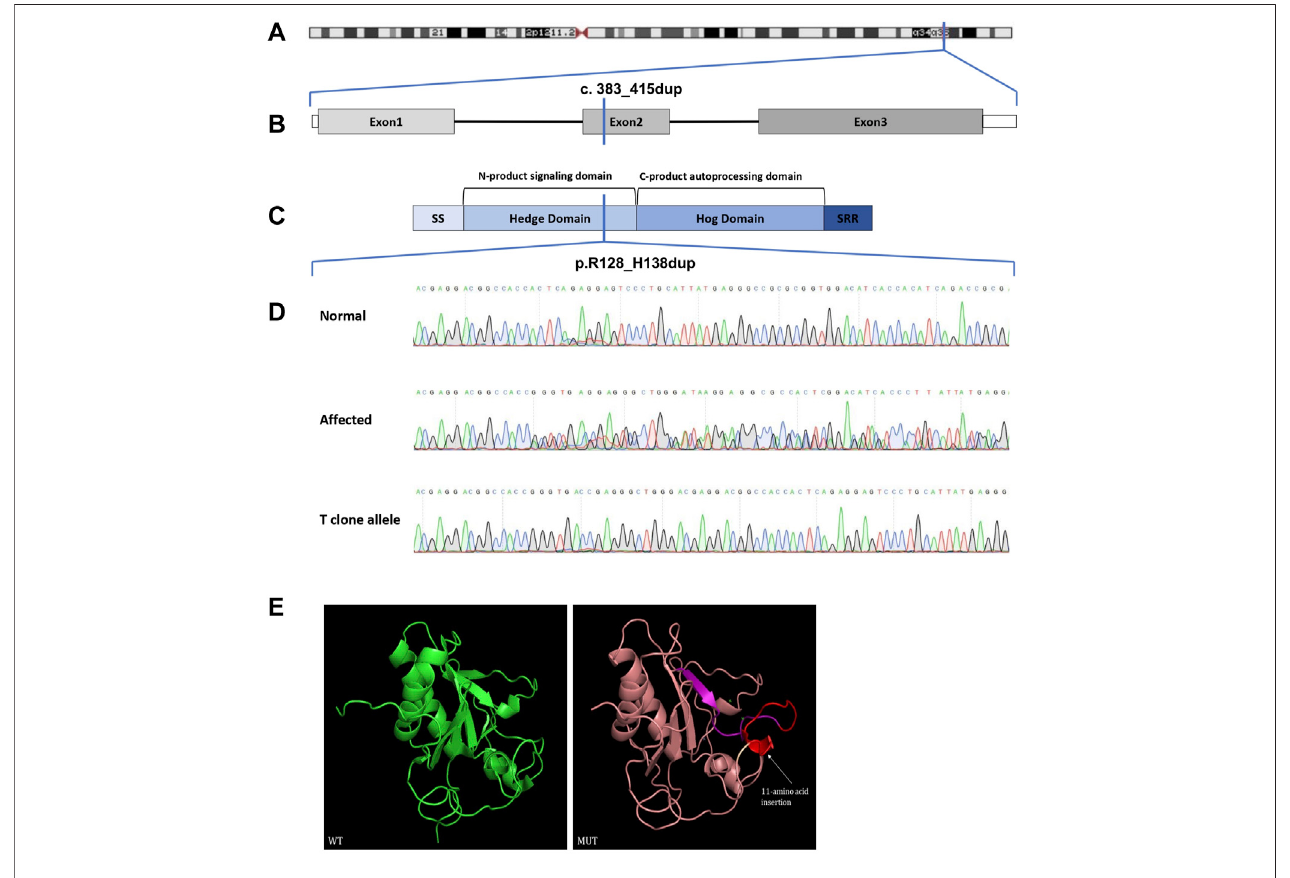
FIGURE 3 | Chromosome location, gene structure, protein structure, and sequence analysis of the Indian Hedgehog. (A) Chromosome 2 and the location of IHH drawn to scale. (B) Genomic DNA map for IHH . (C) IHH protein structure with key domains, regions, and the mutation indicated (SS: signal sequence; SRR: sterol recognition region). (D) Sanger sequencing chromatograms. (E) Three-dimensional structure modeling of wild-type and mutant proteins. The insert 11-amino acid sequence (red) is same as the forward sequence (purple). WT, wild-type; MUT, mutant.